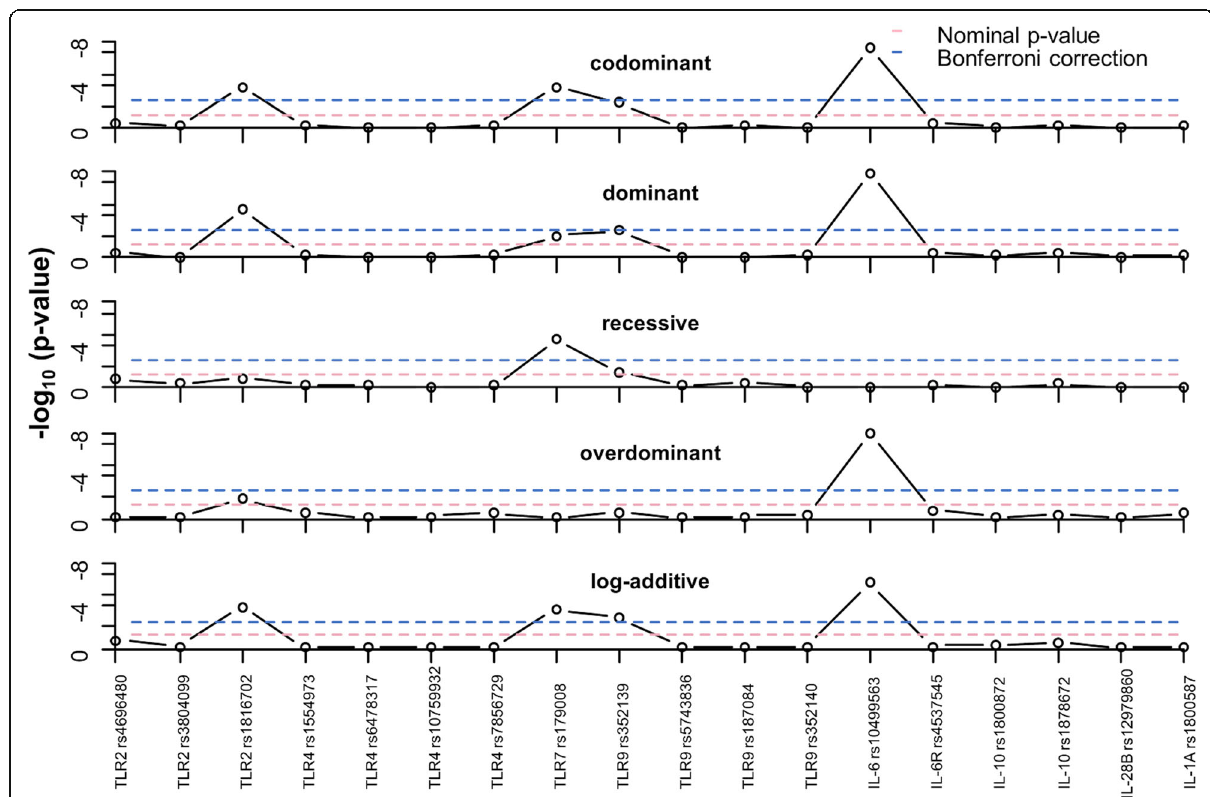
Fig. 1 Plot of log 10 p -values for the association of gene with CMV DNA across models of genetic associations. For each figure panel, the lower dotted horizontal line is for the nominal p -value threshold for significance (0.05), while the upper dotted blue line for the Bonferroni